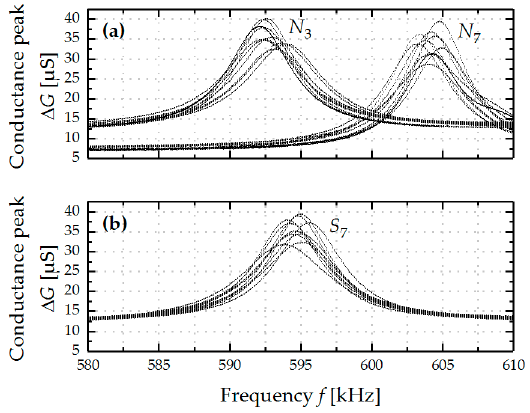
Figure 5. Precision evaluation on the basis of two model solutions of an ordinary fermented grape must in ( a ), and of a stuck fermented grape must in ( b ) at 22 °C.